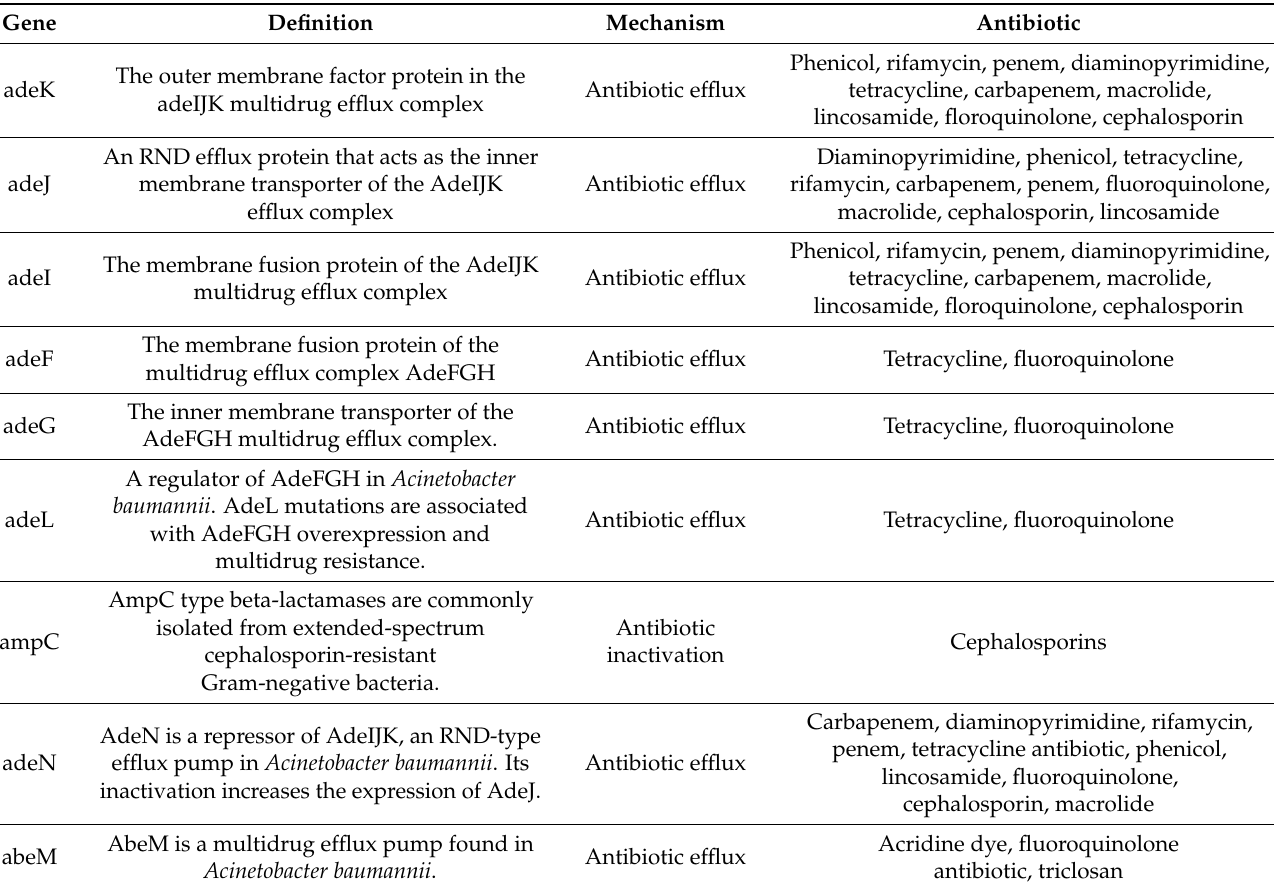
Table 1. Description of the genes present in the core resistome of the studied strains containing the mechanisms of action and antibiotics associated with these mechanisms